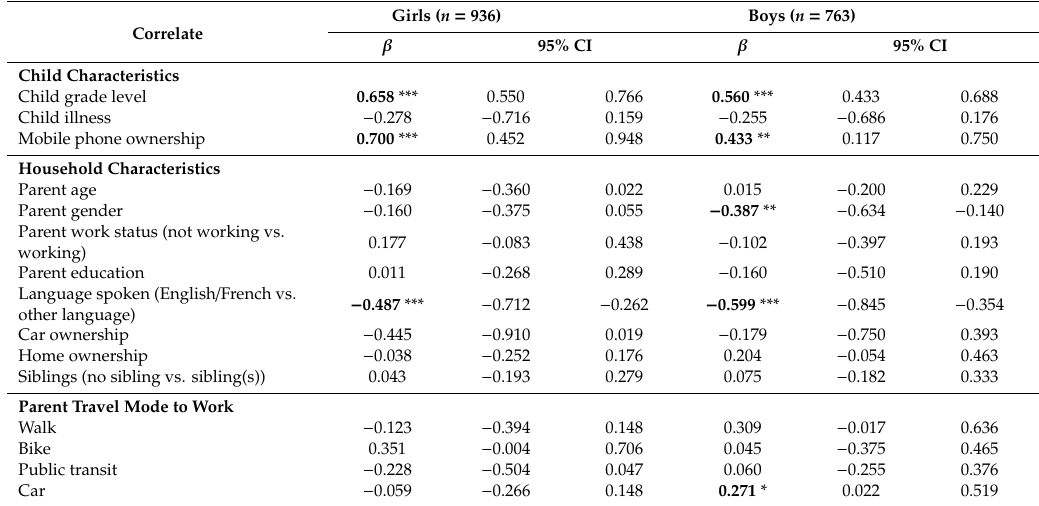
Table 2. Individual-level correlates of children’s independent